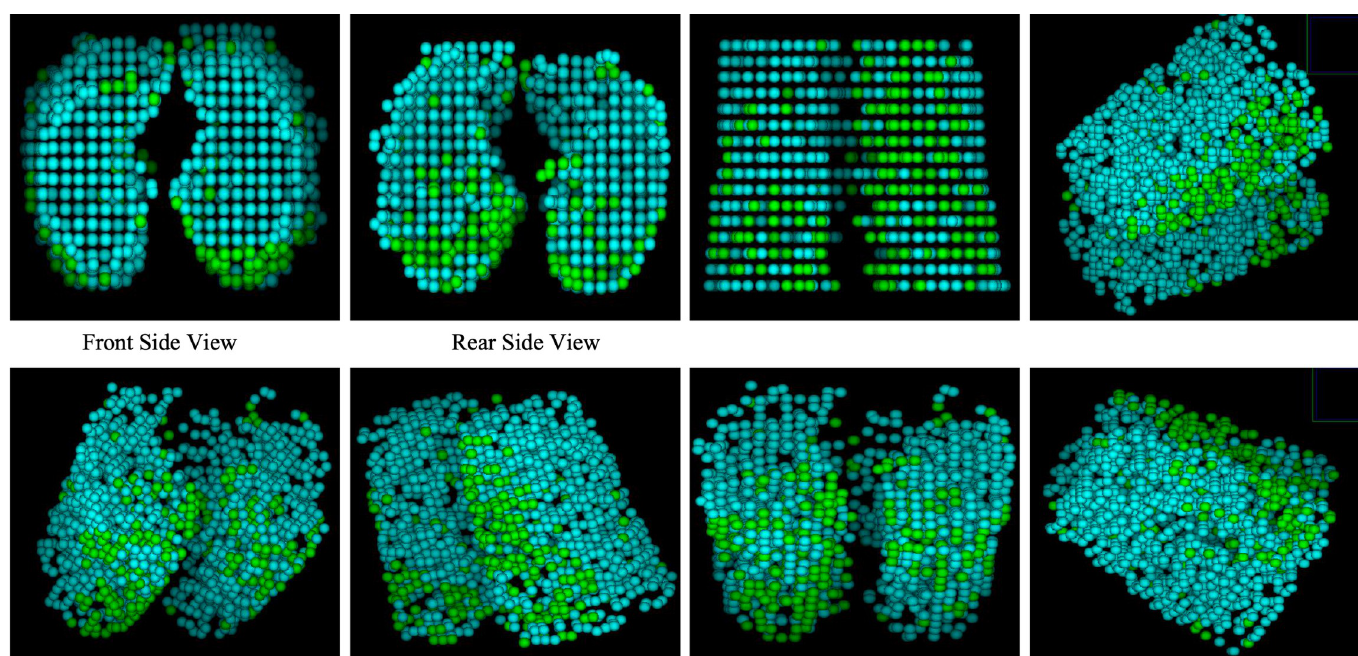
Fig 4. Final results after training the PointNet++ using point cloud data are shown here. The 3D images show different regions from different angles. Cyan color points/bubbles represent non-GGO regions and green color points/bubbles represent GGO regions.